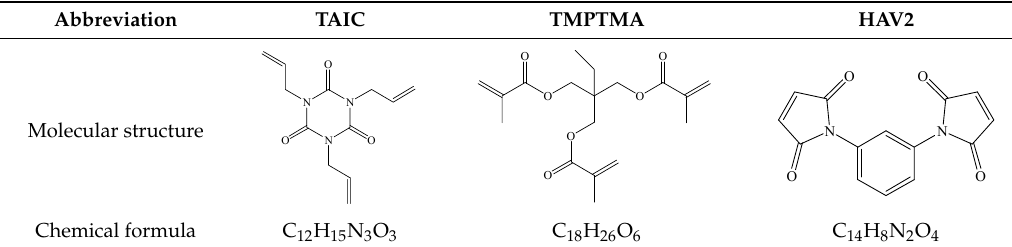
Table 3. Molecular structures of auxiliary crosslinkers.